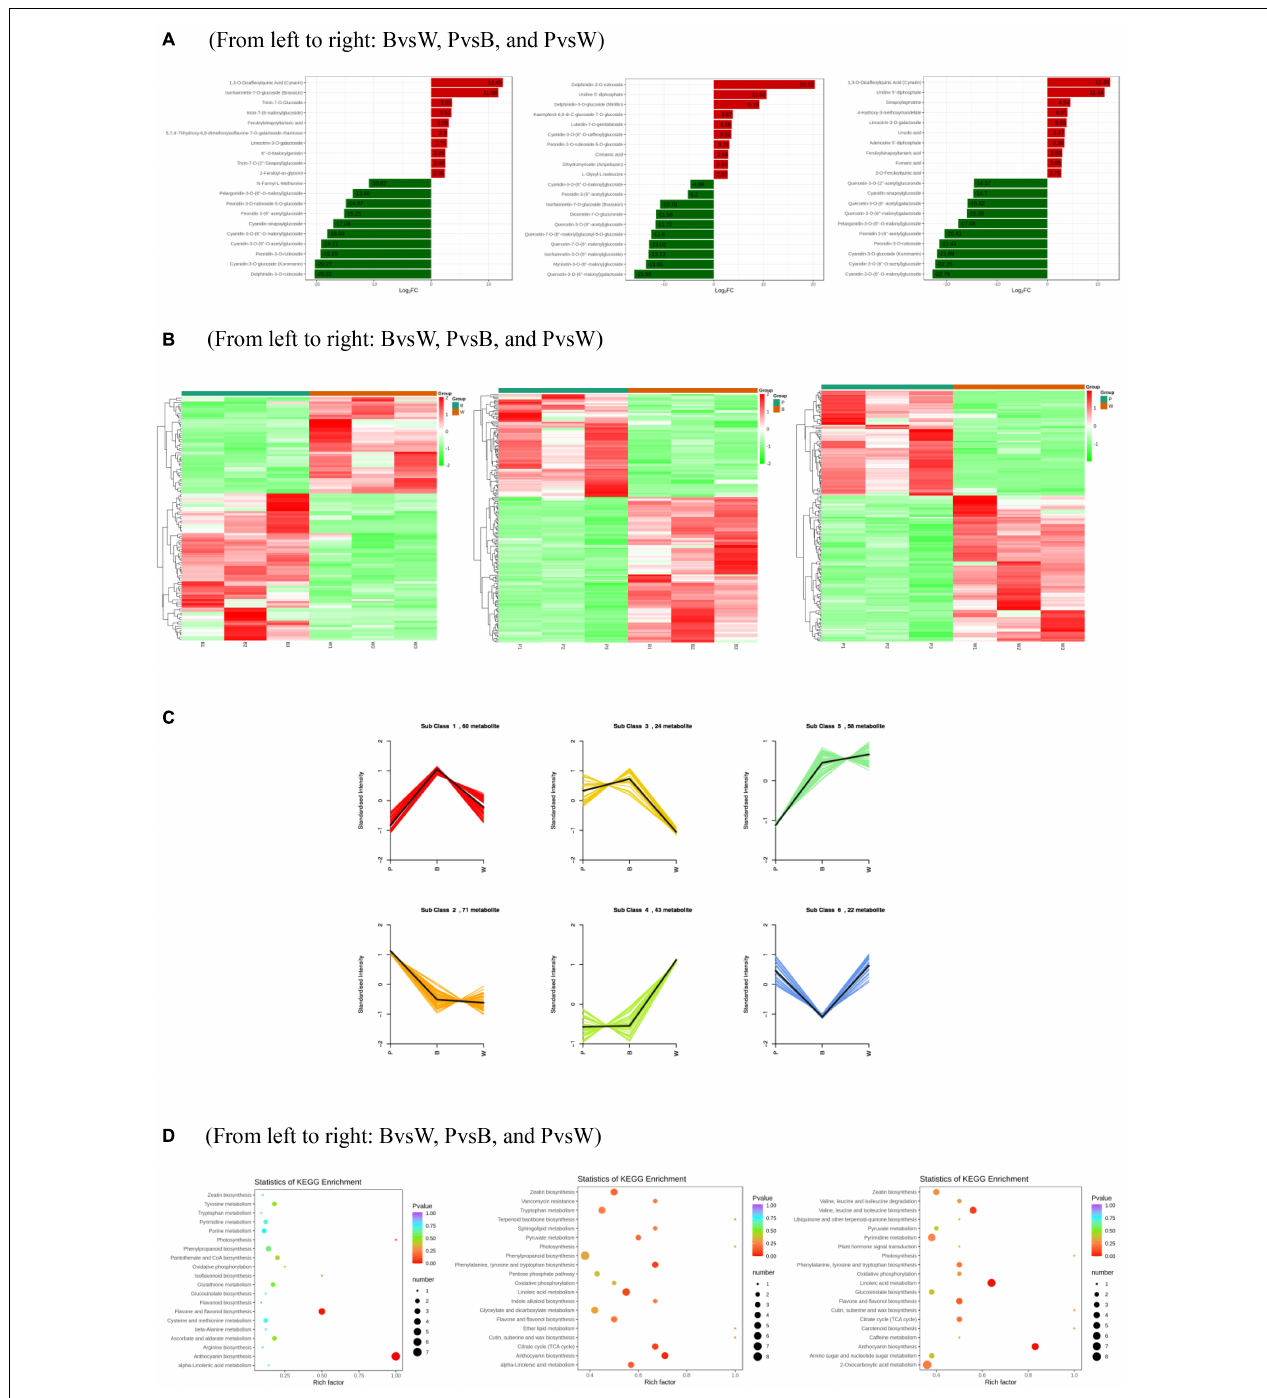
FIGURE 4 | (A) Differentially expressed metabolite bar graph. Horizontal coordinates are log2FC of differential metabolites and vertical coordinates are differential metabolites. Red represents up-regulated differentially expressed metabolites, green represents down-regulated differentially expressed metabolites. (B) Differentially expressed metabolite clustering heat map. (C) K means analysis. (D) KEGG enrichment of differentially expressed metabolites. The horizontal coordinate indicates the Rich factor of each pathway, the vertical coordinate is the name of the pathway, and the color of the dot is the P -value, the redder it is, the more significant the enrichment. The size of the dots represents the number of differential metabolites enriched.